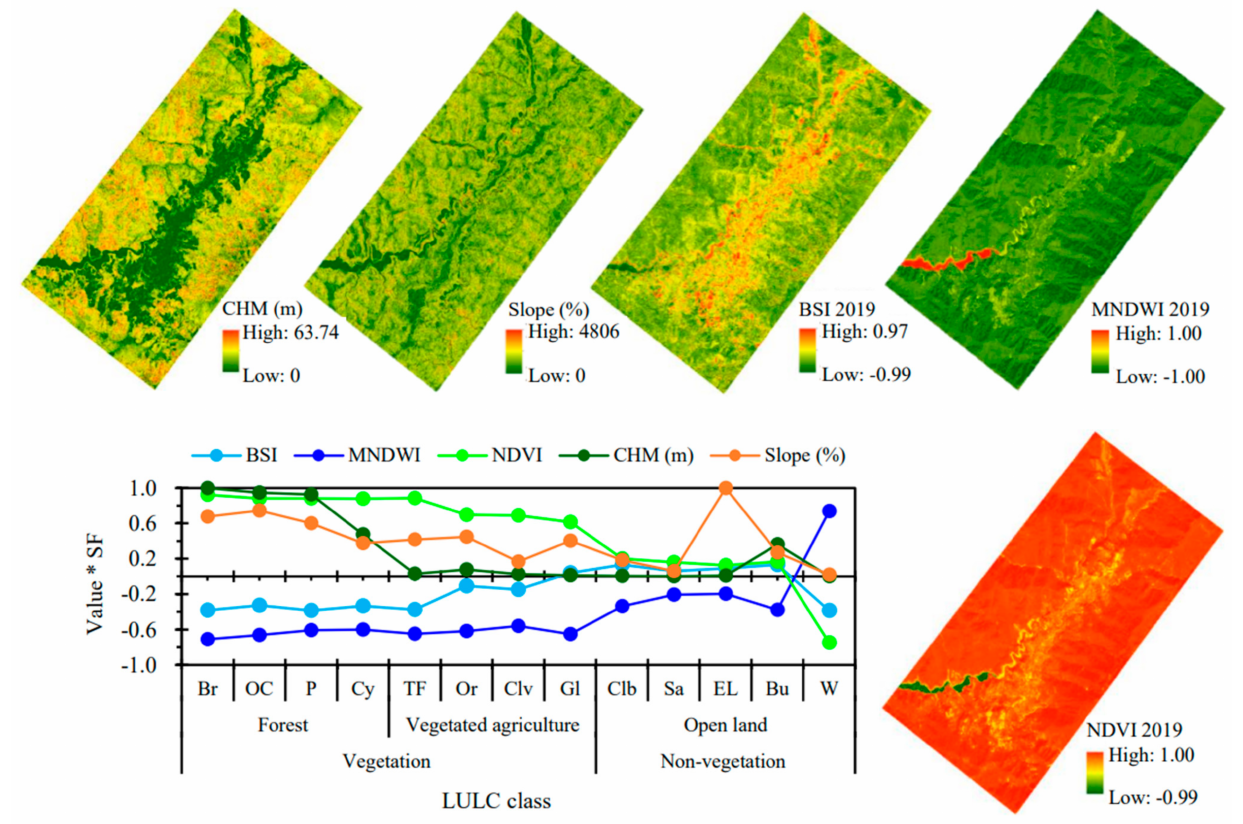
Figure 6. Sentinel-2 and ALS metric maps and average values of the Level-III LULC classes. The scale factor (SF) in the y-axis is 22.41 for CHM, 107.35 for slope, and 1 for BSI, MNDWI, and NDVI. The metrics revealed a dissimilarity among the classes beneficial for generating the RF model. Refer to Table 1 for the meaning of class code in the line graph. Table 2. A joined confusion table of RF and SVM classifiers * at the Level-III LULC classification. ObservedLULC